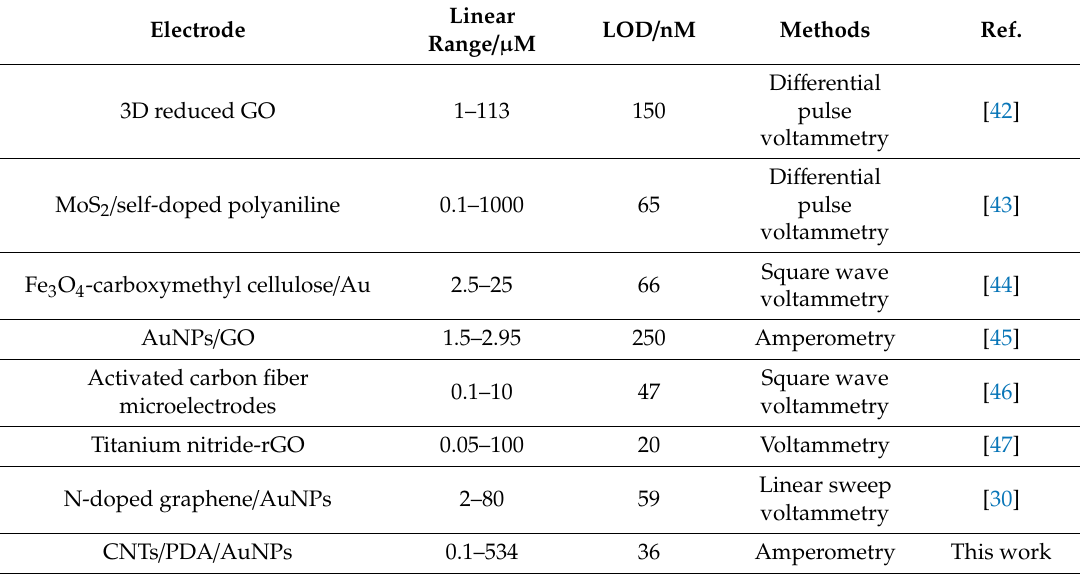
Table 1. Comparison of analytical parameters for the determination of CAP at CNTs / PDA / AuNPs nanocomposite film with reported